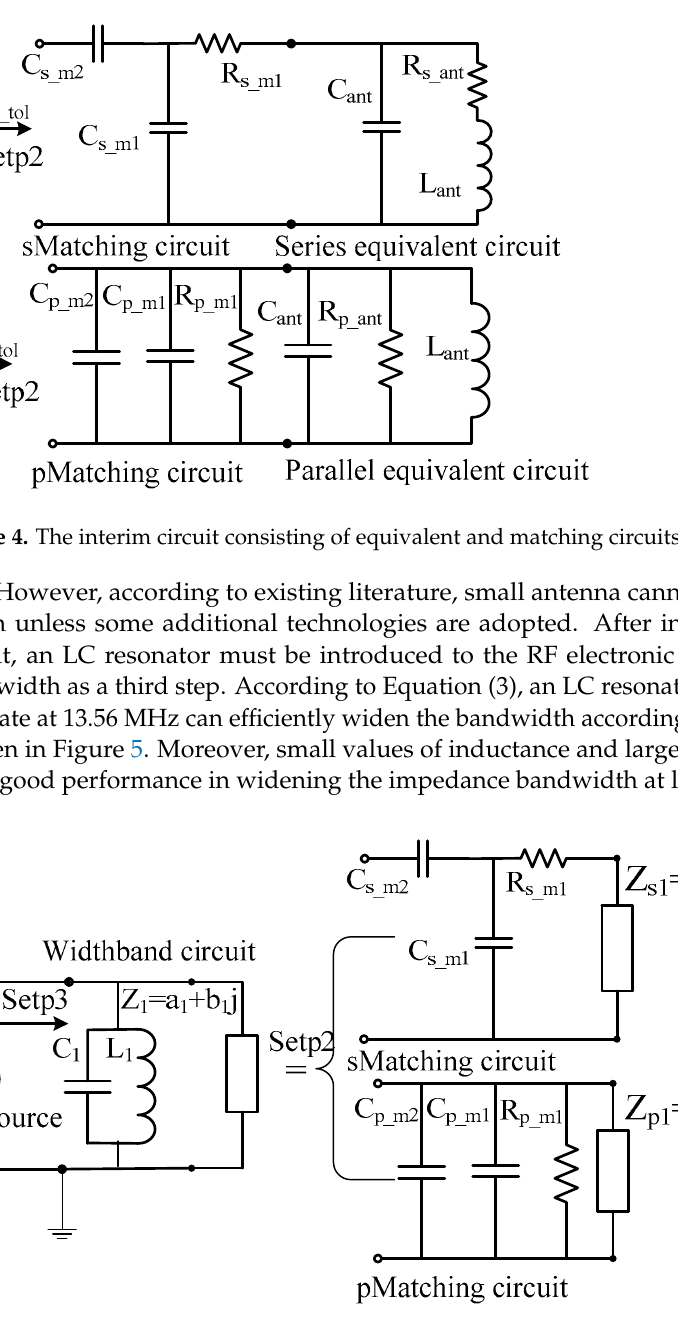
Table 2. Possible values of inductance and capacitance. L1 (nH)